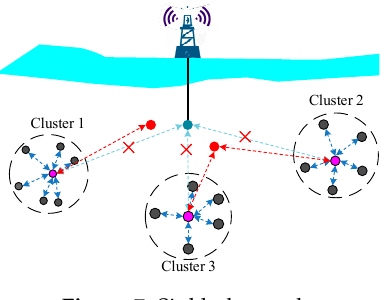
Figure 7. Sinkhole attack.